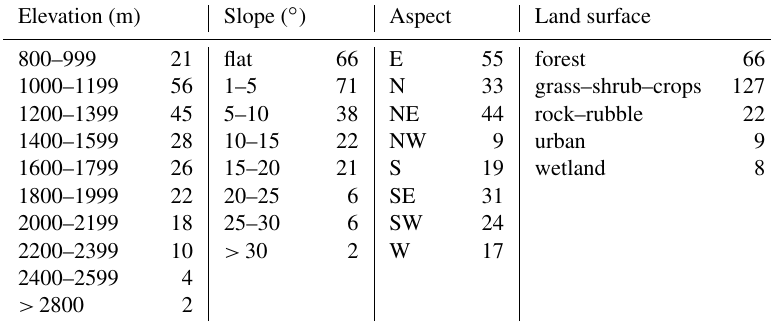
Table 1. The number of sites having different elevation, slope, aspect, and land surface types. Elevation (m) Slope ( ◦ )